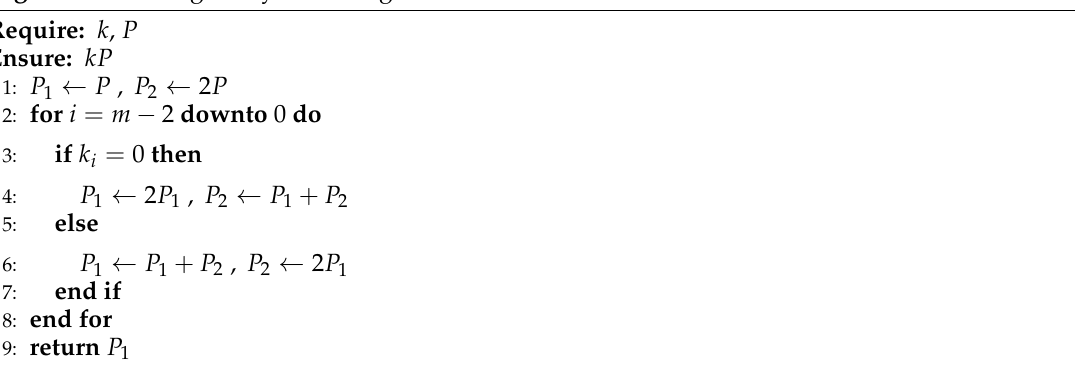
Algorithm 1 Montgomery ladder algorithm